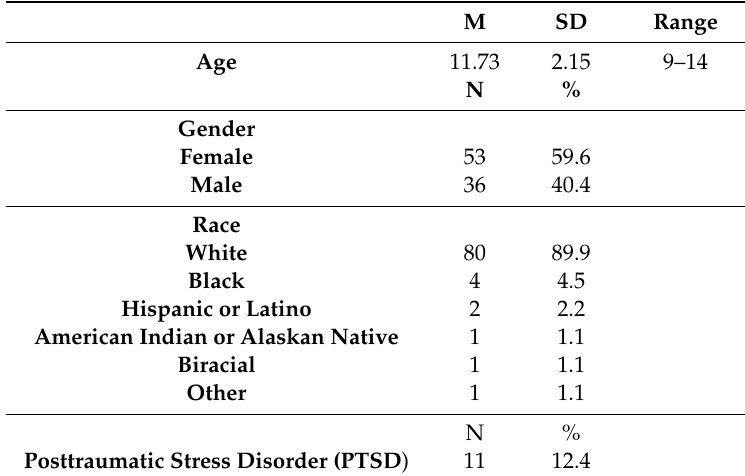
Table 1. Participant characteristics (N =